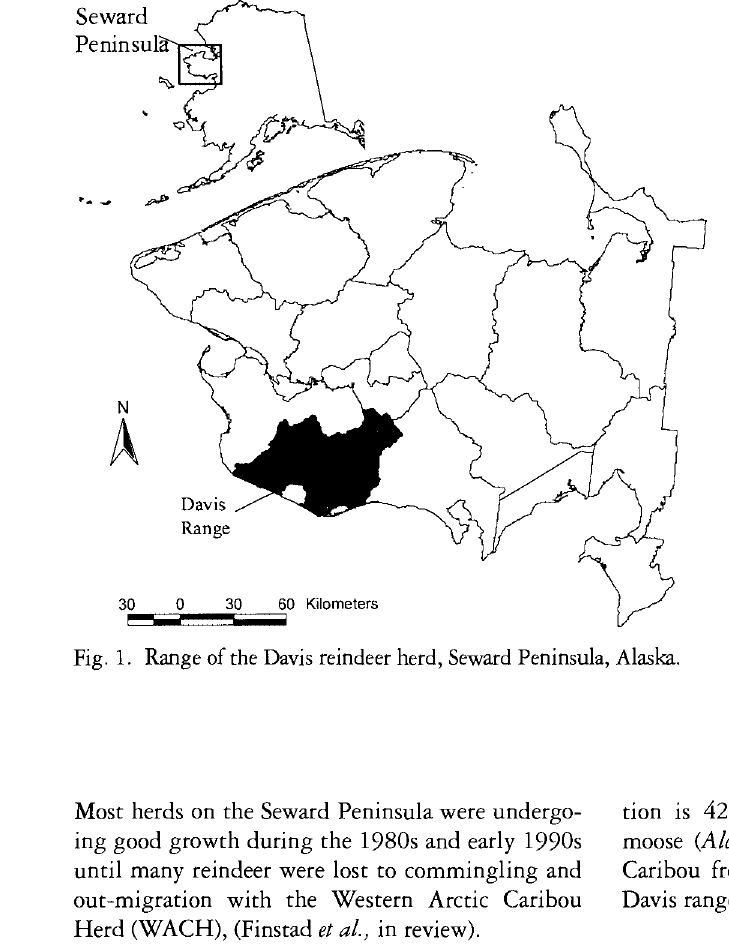
Most herds on the Seward Peninsula were undergo ing good growth during the 1980s and early 1990s until many reindeer were lost to commingling and out-migration with the Western Arctic Caribou Herd (WACH), (Finstad et al, in